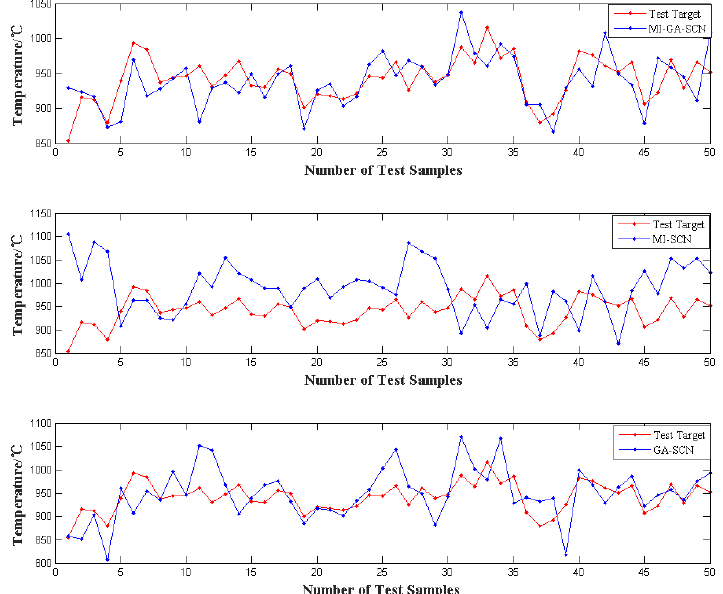
Figure 4. Fitting of incinerator temperature by MI-SCN , GA-SCN and MI-GA-SCN.